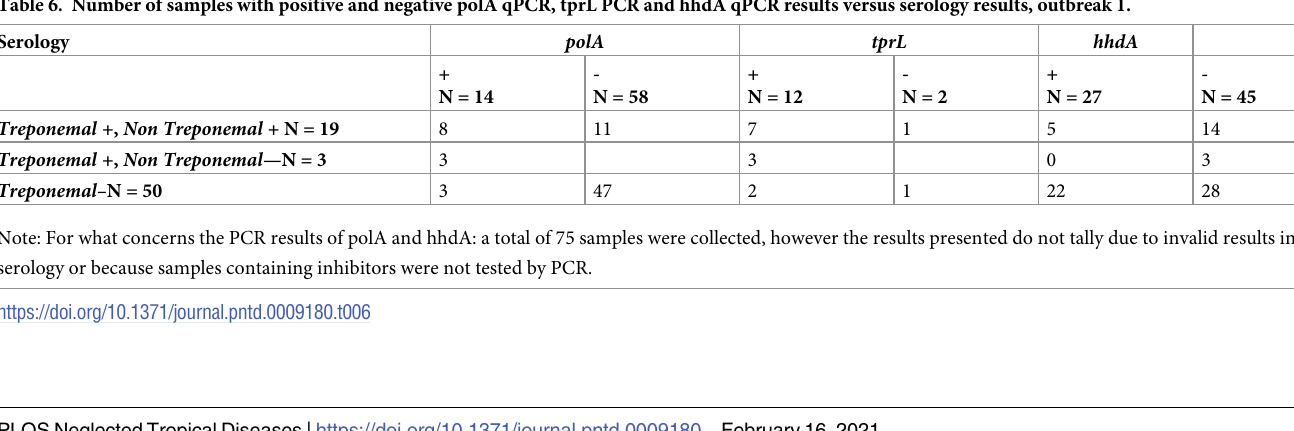
Table 6. Number of samples with positive and negative polA qPCR, tprL PCR and hhdA qPCR results versus serology results, outbreak 1. Serology polA